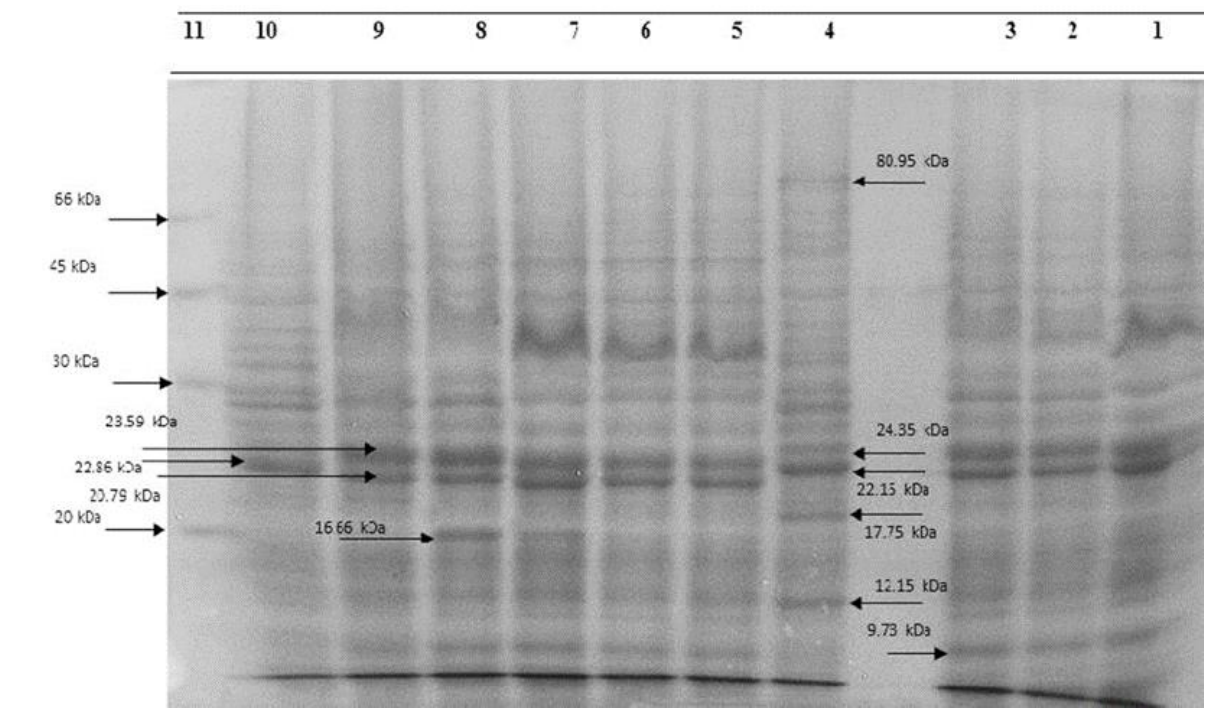
Figure 2. Sodium dodecyl sulfate – polyacrylamide gel electrophoresis whole-bacteria protein profiles of E. coli strains from ice cream. Lane 1, 13 (phenon 1); Lane 2, 1 (phenon 1); Lane 3, 2 (phenon 1); Lane 4, 3 (phenon 1); Lane 5, 5 (phenon 1); Lane 6, 7 (phenon 1); Lane 7, 11 (phenon 1); Lane 8, 12 (phenon 1); Lane 9, 10 (phenon 1); and Lane 10 (reference strain) E. coli ATCC 25922.